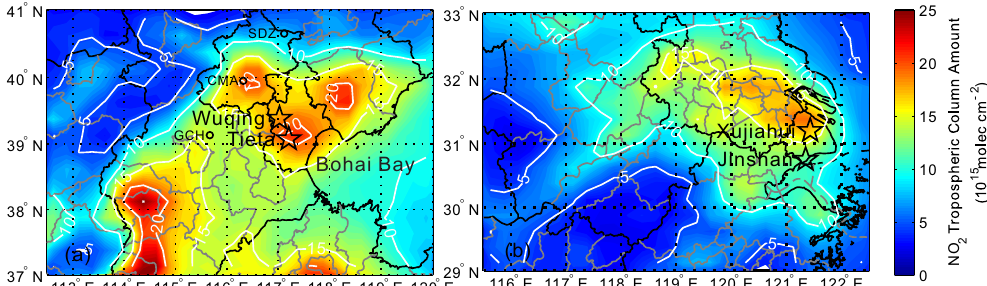
Fig. 1. Average NO 2 distributions during March 2009–2010 obtained from OMI (Ozone Measuring Instrument) Level 3 data in a resolution of 0.25 ◦ ×0.25 ◦ (a) in the NCP; (b) in the YRD. The white lines are contour lines of NO 2 tropospheric column amounts. The black lines display the borders of provinces and coastlines. The grey lines show the borders of